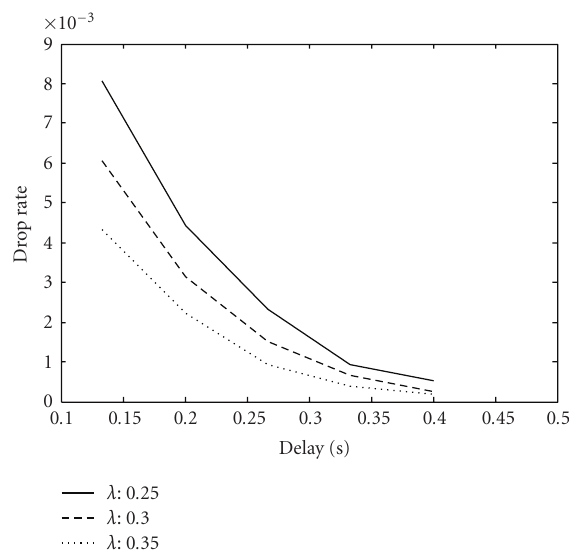
Figure 15: Data drop rate versus bu ff ering delay for multiplexed services by 3 di ff erent values for λ